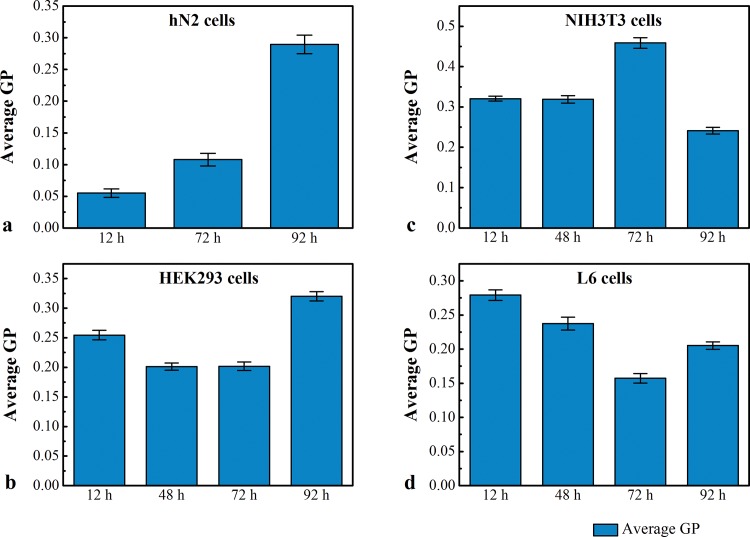
GP distribution in a) hN2, b) HEK293, c) NIH3T3 and d) L6. a) Histograms of GP distributions among hN2 cells at 12 h, 48 h, 72 h and 92 h respectively. At 72 h GP reached minimum values (0.17) ± SEM and increased to 0.28 ± SEM after 92 h. 10 cells were analyzed for each time point for statistical significance. b) Histograms of GP distributions among 10 HEK293 cells at 12 h, 48 h, 72 h and 92 h respectively. At 72 h GP values reached minimum values (0.2) ± SEM and increased to 0.327 ± SEM after 92 h. 10 cells were analyzed for each time point for statistical significance. c) Histograms of GP distributions among 10 NIH3T3 cells at 12 h, 48 h, 72 h and 92 h respectively. At 72 h GP reached maximum values (0.45) ± SEM and decreased to 0.25 ± SEM after 92 h. 10 cells were analyzed for each time point for statistical significance. d) Histograms of GP distributions among L6 cells at 12 h, 48 h, 72 h and 92 h respectively. At 72 h GP reached minimum values (0.17) ± SEM and increased to 0.22 ± SEM after 92 h. 10 cells were analyzed for each time point for statistical significance.